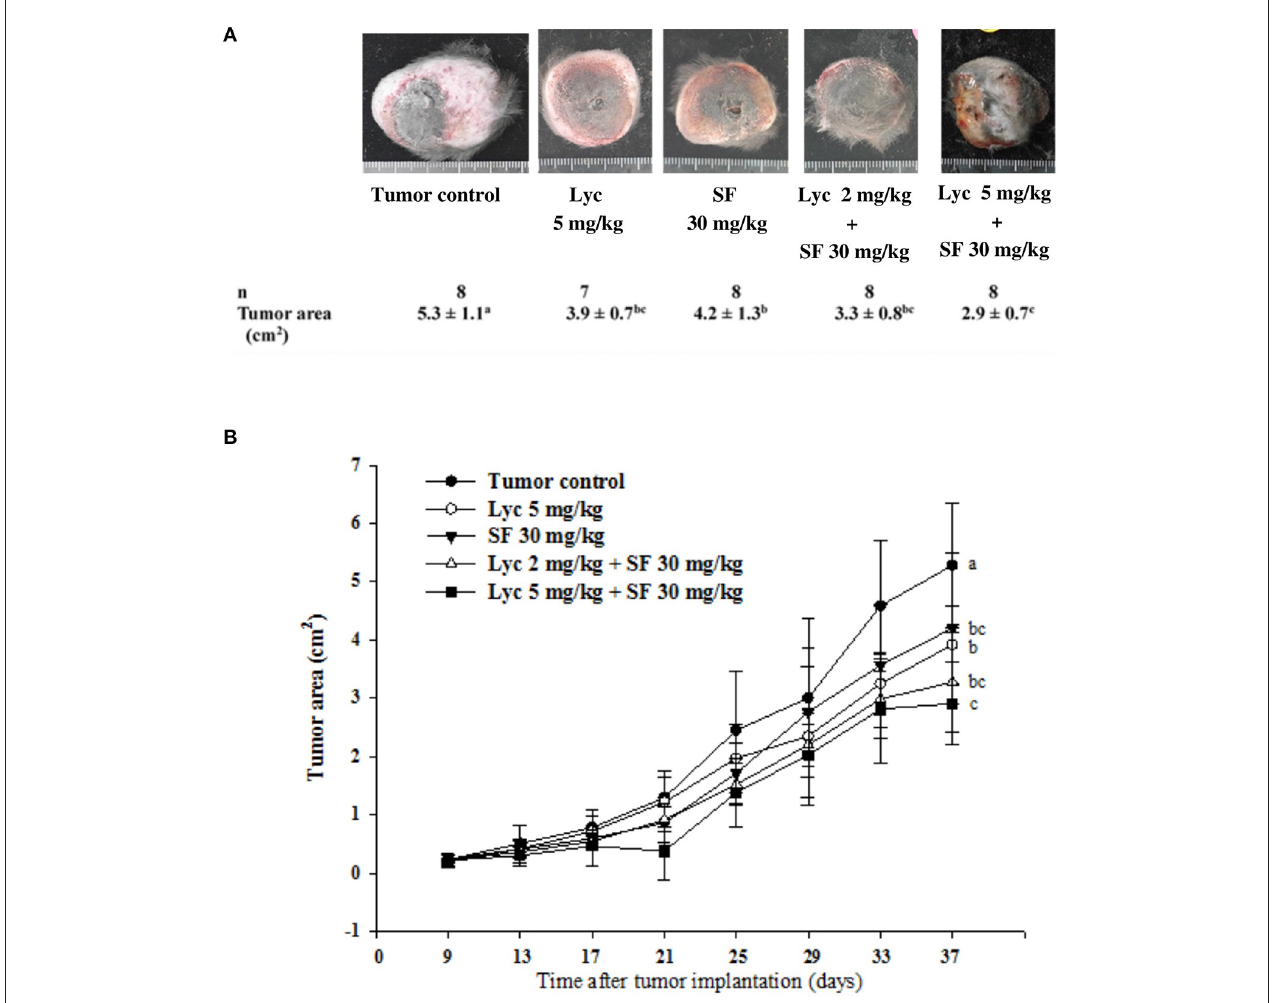
FIGURE 3 | Effects of lycopene (Lyc) alone, sorafenib (SF) alone, or their combination on the primary tumor area in the xenografted mice during the entire experimental period. LLC cells were injected subcutaneously into the right flank of the C57BL/6 mice. Nine days after the tumor cell injection, the mice were orally supplemented with SF (30 mg/kg) daily, Lyc (5 mg/kg) twice per week or the combined treatment [mice were supplemented with SF (30 mg/kg) daily, and Lyc (2 and 5 mg/kg) twice per week] for 28 days. The formula for calculating the tumor area is: π ÷ 4 × length × width. (A) Images of primary tumor. (B) The quantitative results